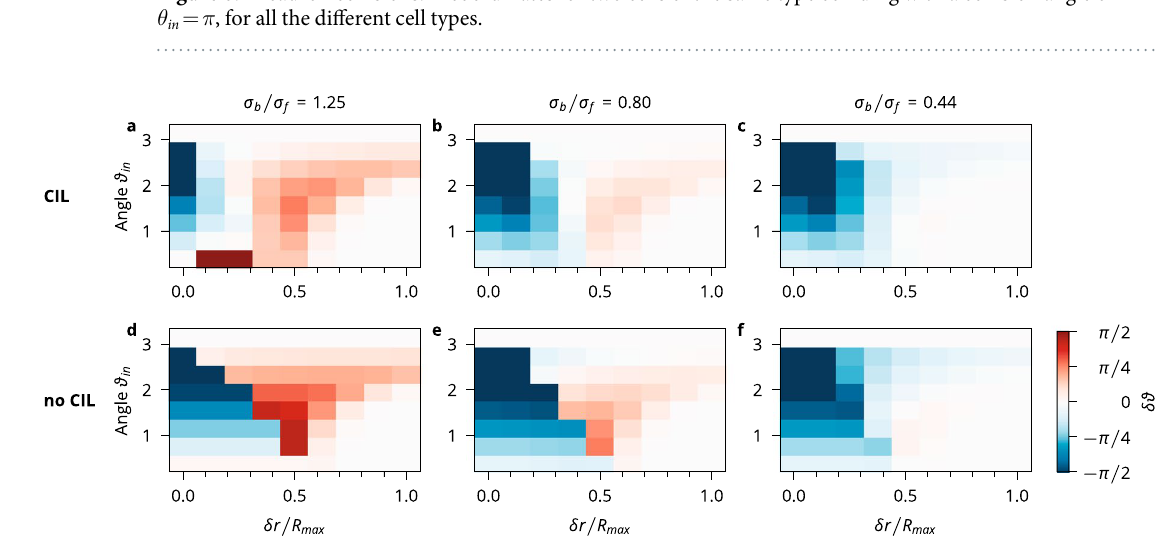
Figure 7. Polar order due to cell shape. Difference δϑ between outgoing and incoming angles as a function of the incoming angle ϑ in and δ r , which is the difference in the distances of the cells from the collision centre before the